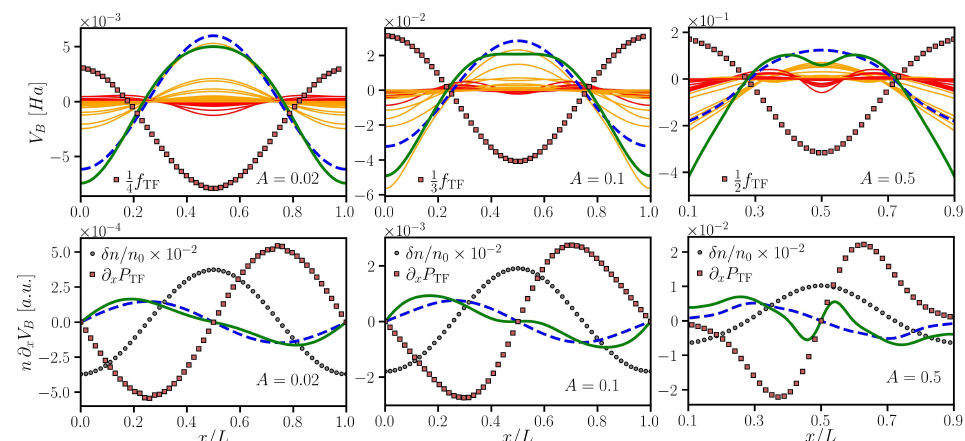
Figure 2: Upper panel: Comparison of the exact many-fermion Bohm potential (thick = 2 and % θ = 1. Ad- green) with the standard Bohm potential (dashed blue) at r s ditionally, the TF free energy density (red squares, scaled) and the contributing KS orbitals are illustrated (thin red (dark) and orange (light) lines for the contribu- tions with the local maximum and minimum in the central region, respectively). The contribution of orbitals is scaled by a factor two (three) at A = 0.02 ( A = 0.1 and A = 0.5). Lower panel: Comparison of the forces from the many-fermion Bohm po- tential (green) with forces from the standard Bohm potential (dashed blue). We also display the TF pressure (squares) and the density profile (grey circles). Note the